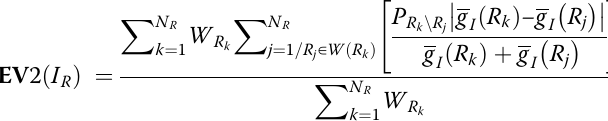
of penalizing the over segmentation. (Formula intra-